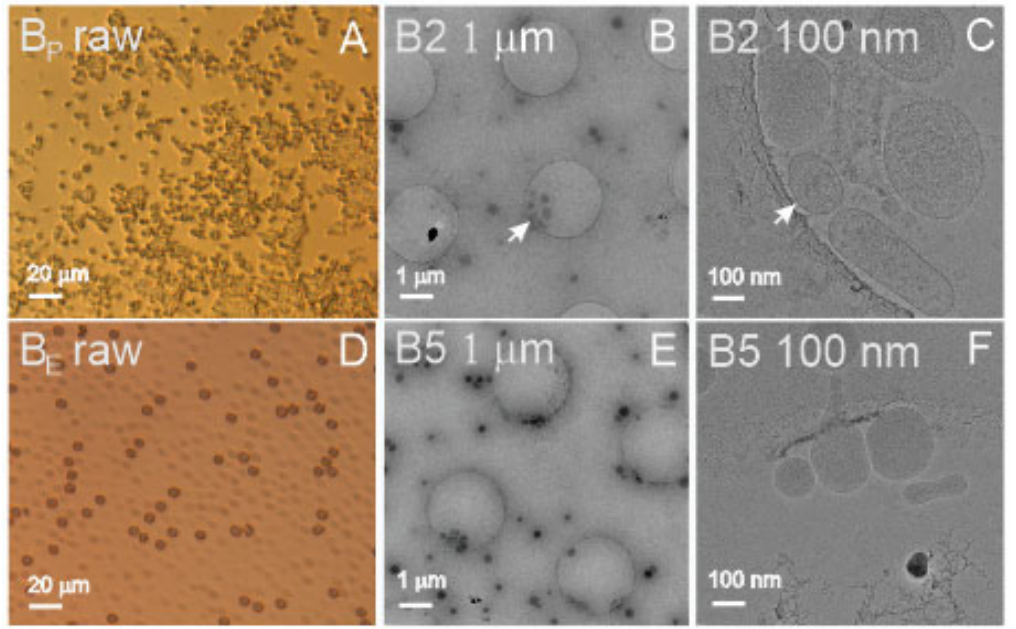
Figure 1. Visualization of blood-derived samples ( A ): blood plasma, ( B , C ): isolate from blood plasma, ( D ): suspension of washed, aged erythrocytes, ( E , F ): isolate from washed, aged erythrocytes. ( A , D ): light microscopy; ( B , C , E , F ): cryo-TEM microscopy. White arrows in panels ( B , C ) point to the same spot. Labels in the upper left corner correspond to labels in the raw data (DOI: 10.5281/zenodo.7178202).